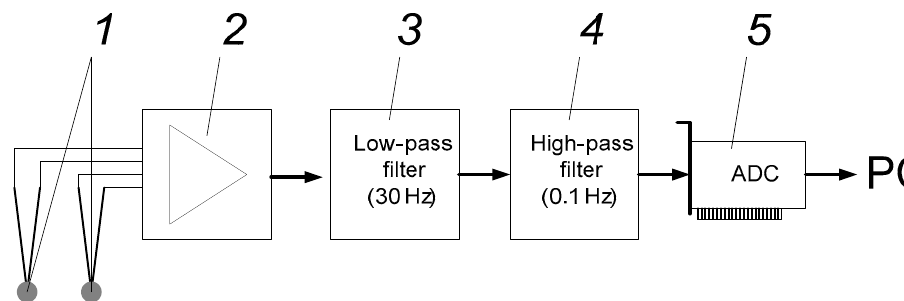
Figure 8. Measuring circuit. 1 —thermocouples; 2 —amplifier; 3 —filter; 4 —filter; and 5 —analog-to- digital converter inserted into a personal computer.